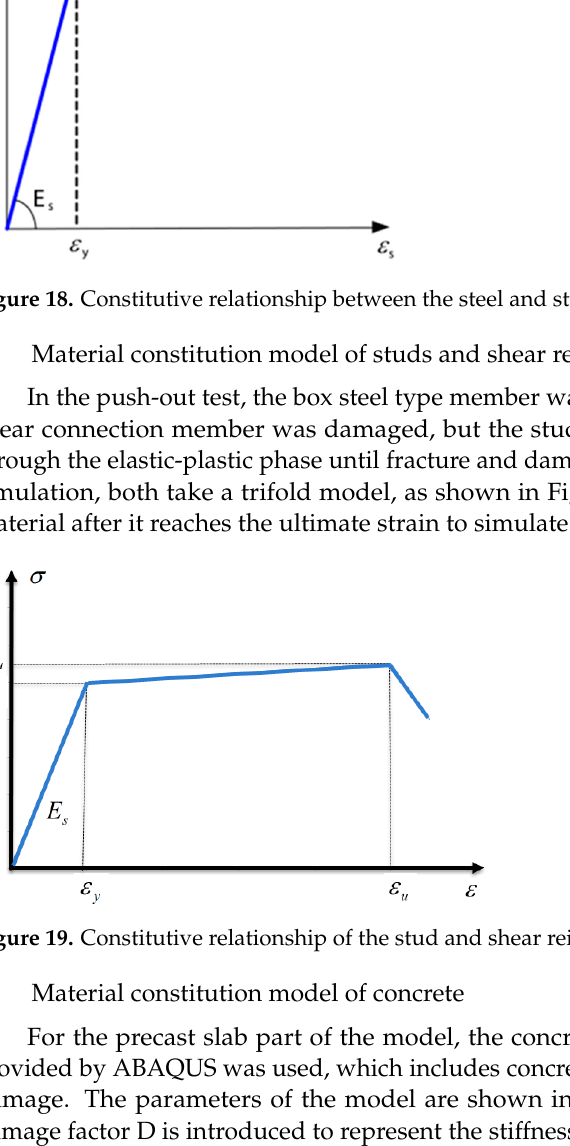
Table 9. Concrete material